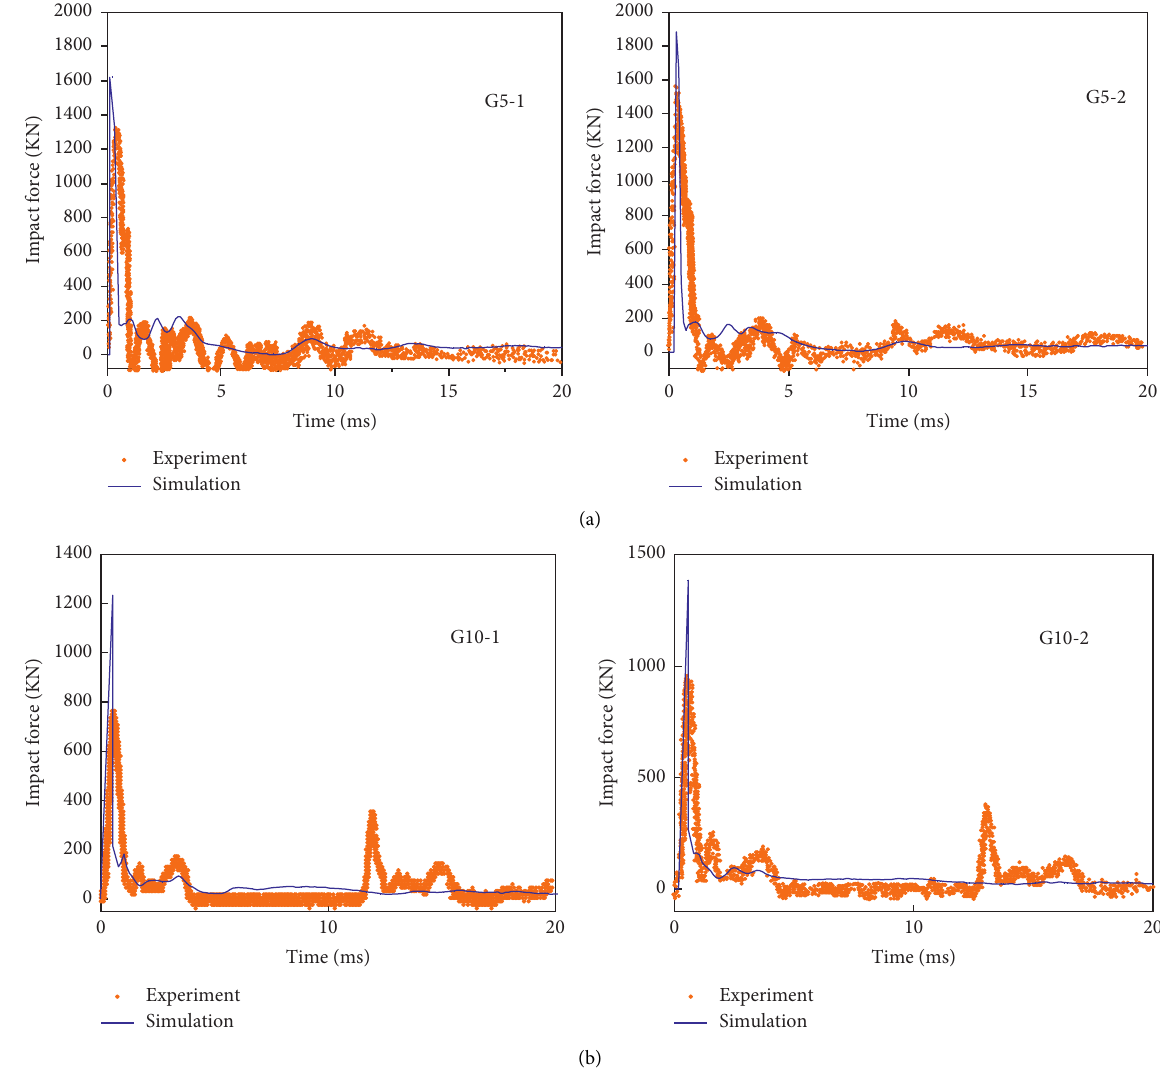
Figure 11: Comparison of the impact force time histories for RC beams between the simulation and Kishi’s experiments. (a) Series G5. (b) Series